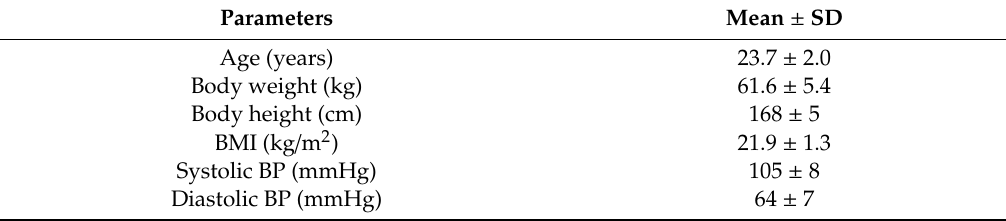
Table 1. Baseline characteristics of the